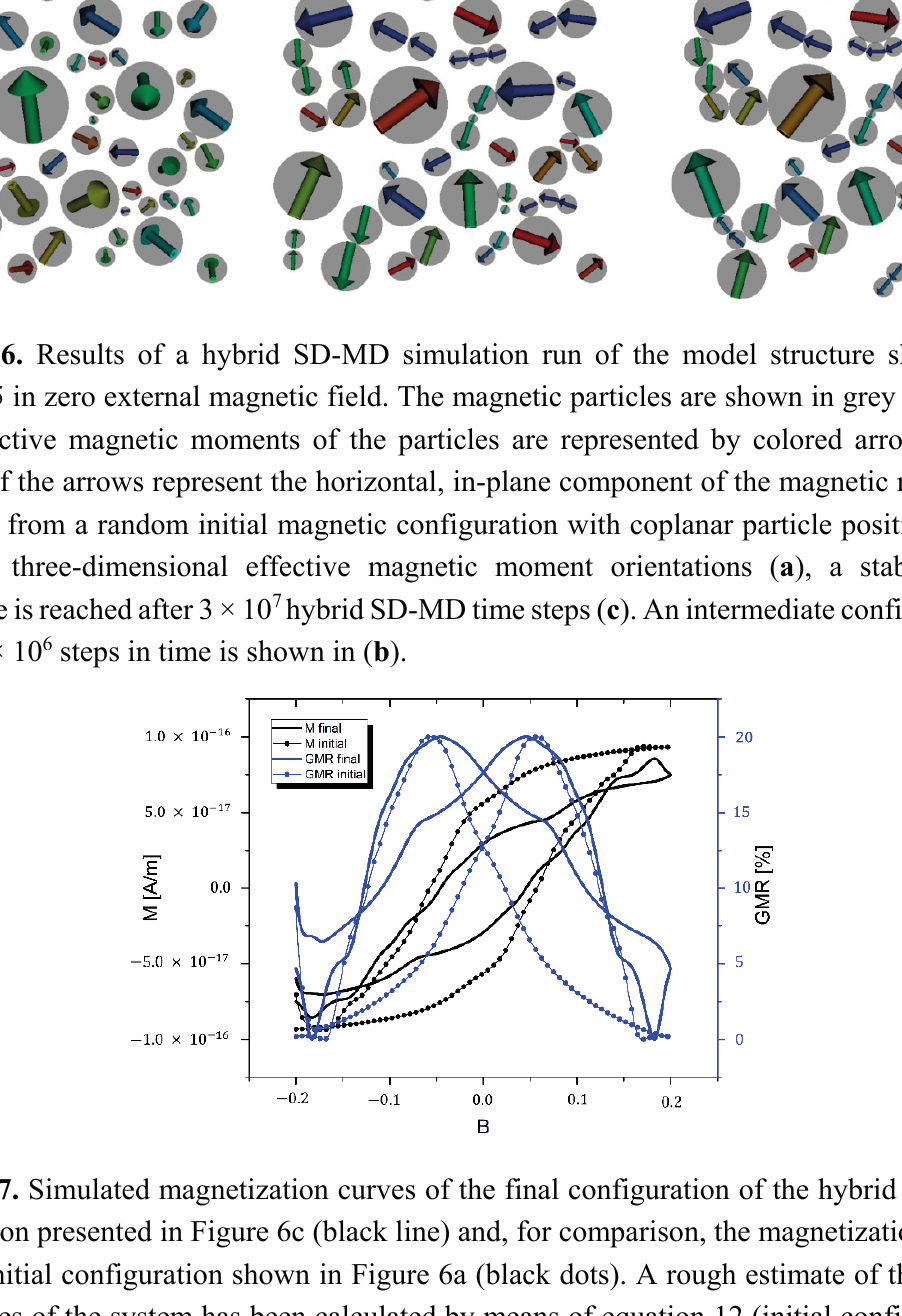
of 20% (cid:3008)(cid:3014)(cid:3019)